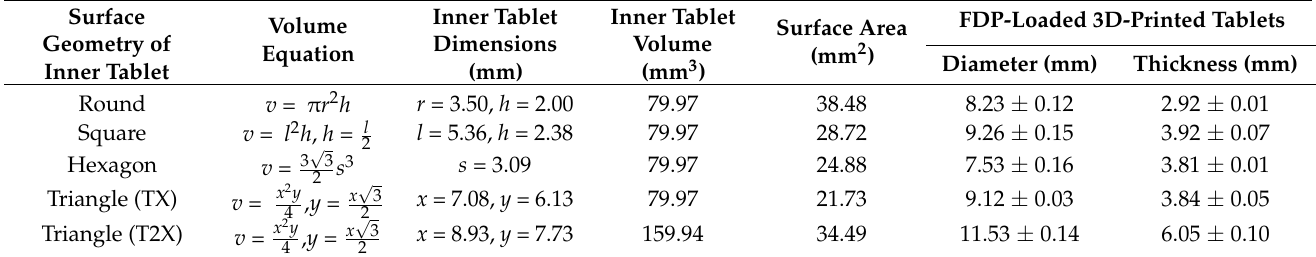
Figure 1. Design of FDP-loaded 3D-printed tablets with different internal surface geometries (left to right; round, square, hexagon, and triangle). Table 1. Physical parameters for FDP-loaded 3D-printed tablets with an inner compartment volume constant.